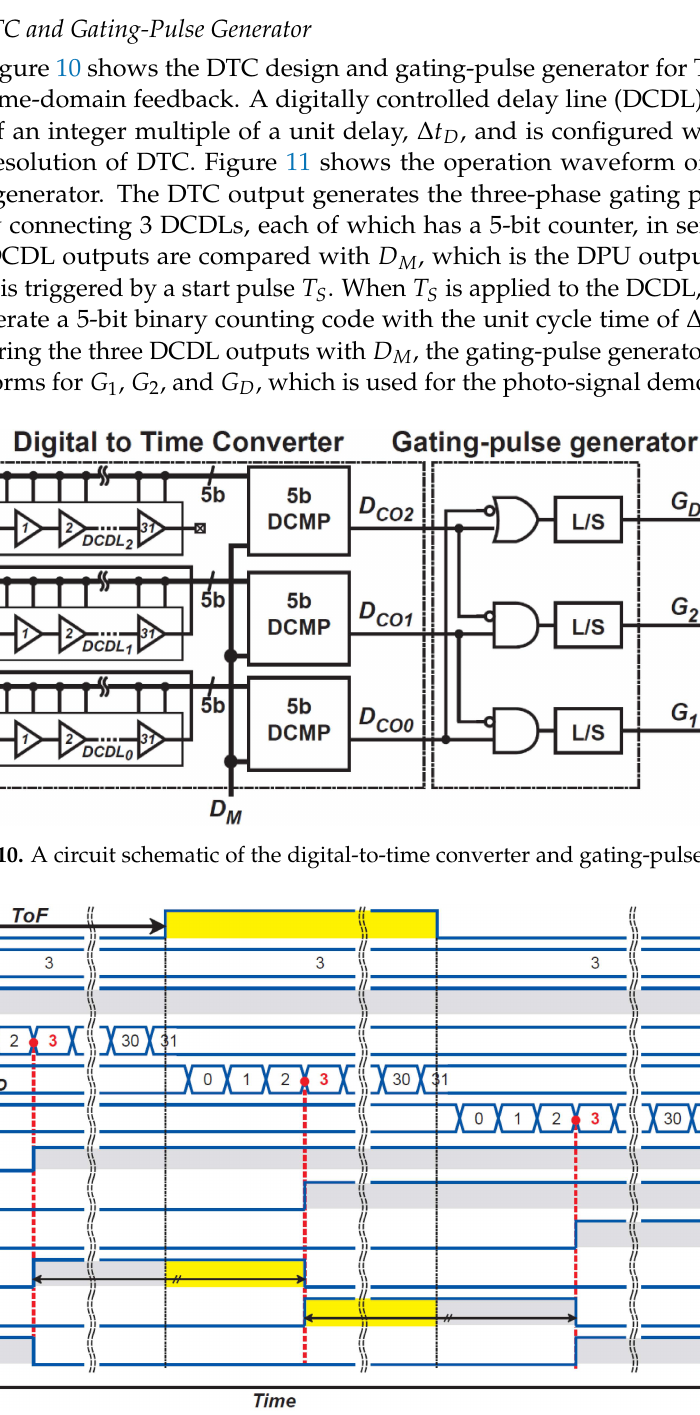
Figure 11. Conceptual operation waveform of the digital-to-time converter and gating-pulse